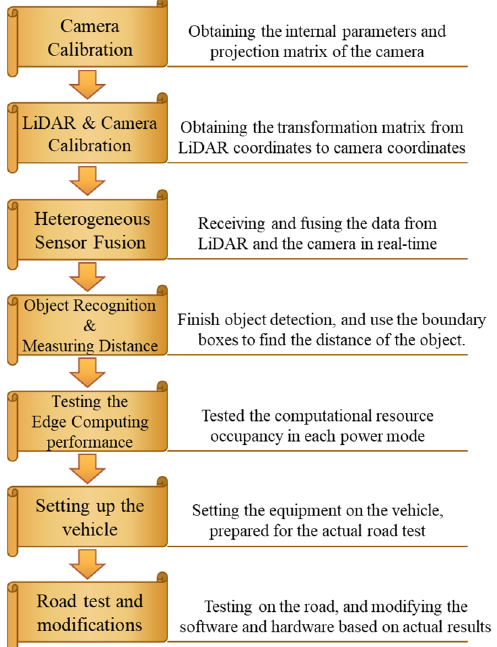
Figure 8. Steps and goals of the experiment.